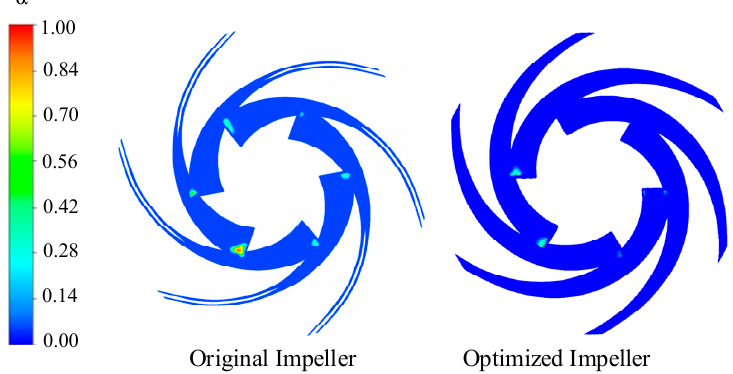
SS PSPS Figure 20. Compare streamline on blade surface at cavitation condition. 4.2.7. Vapor volume fraction analysis at 1.0 Q d . To compare the vapor and bubble distribution within the two schemes, the optimized impeller was first compared with the original impeller at the nominal operating condition. From Figure 21,